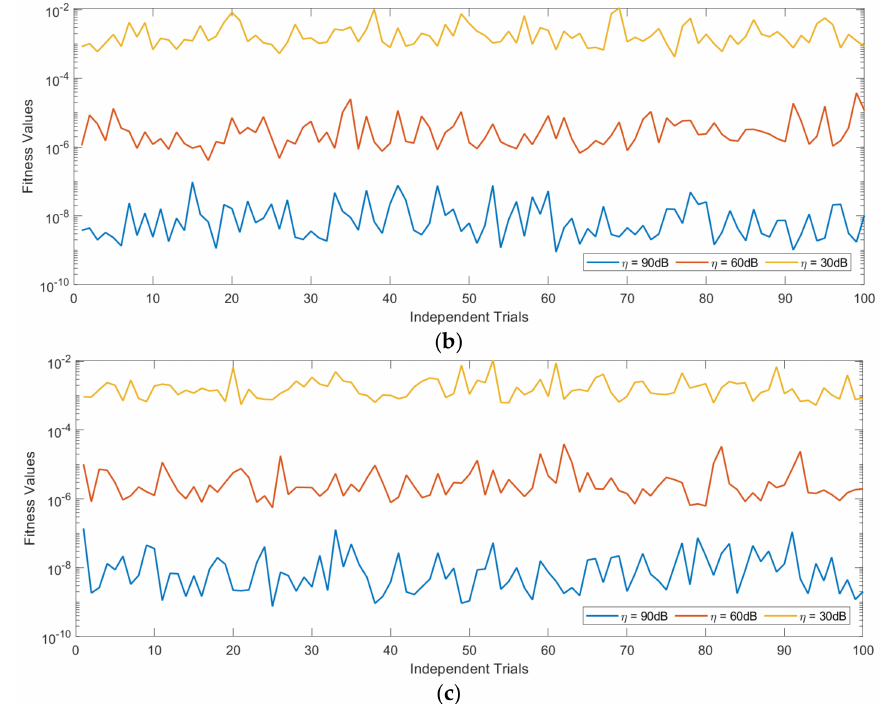
Figure 4. Results of fitness against independent trials ( a ) ε = 0.1 ( b ) ε = 0.2 ( c ) ε = 0.3.